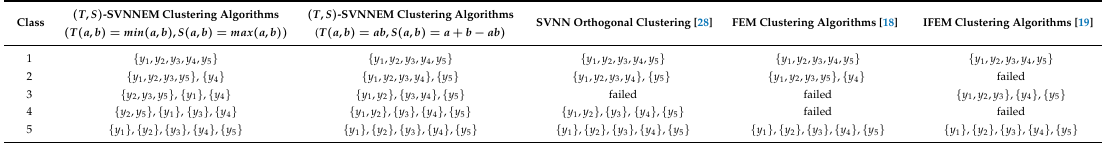
Table 6. Clustering result of five kinds of clustering